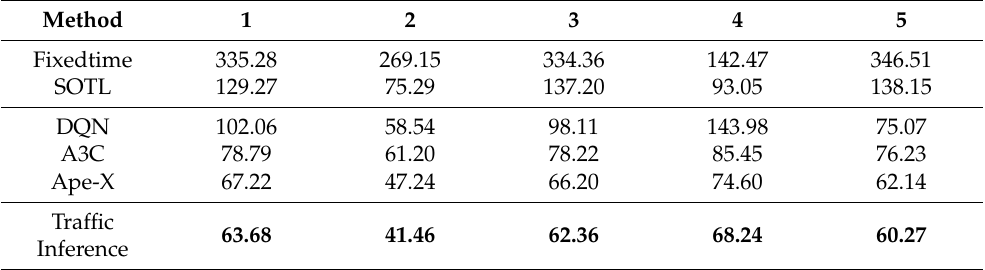
Table 2. Average travel time for the five intersections in Atlanta, in seconds. The bolded result is the optimal result.